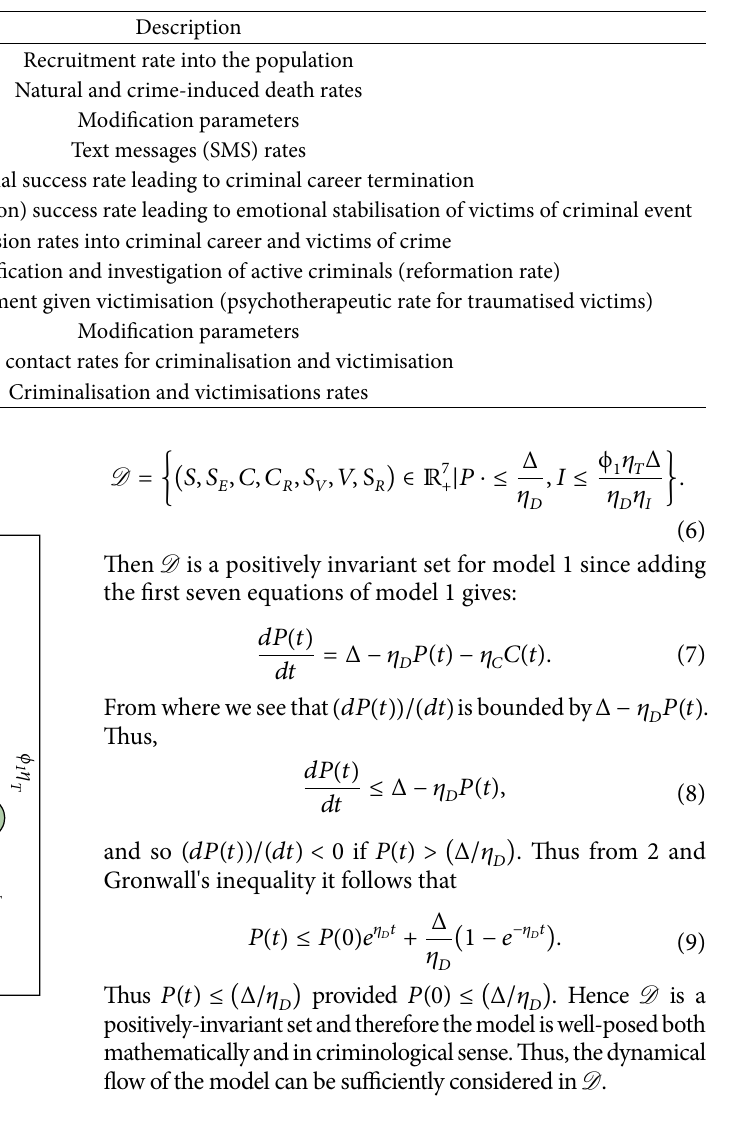
Figure 1: Transfer diagram for the crime model